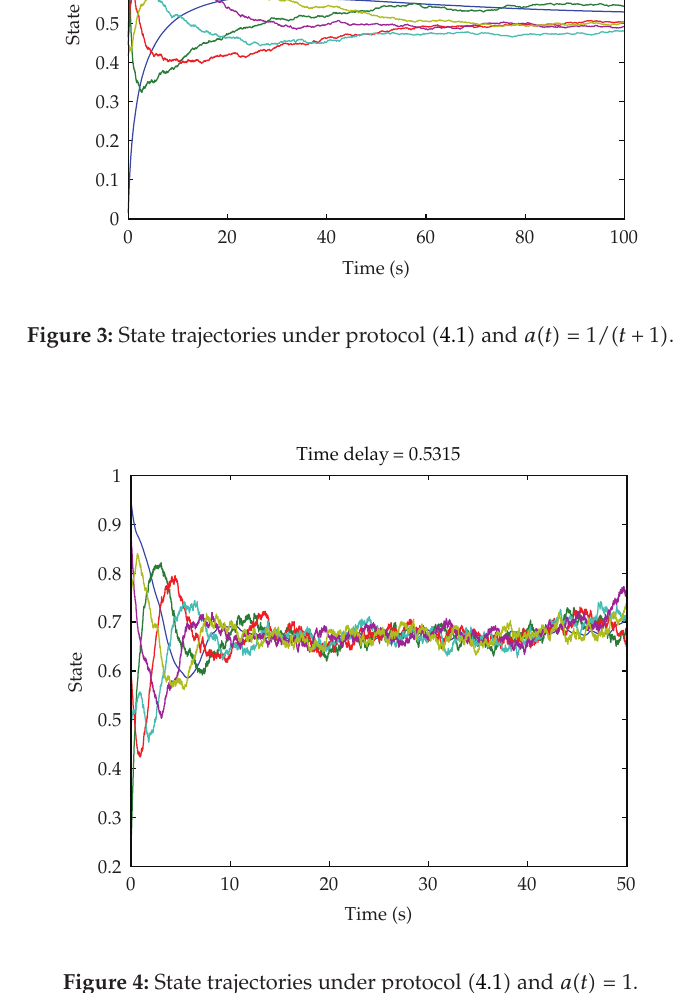
Figure 4: State trajectories under protocol (cid:7) 4.1 (cid:8) and a (cid:7) t (cid:8) (cid:6)